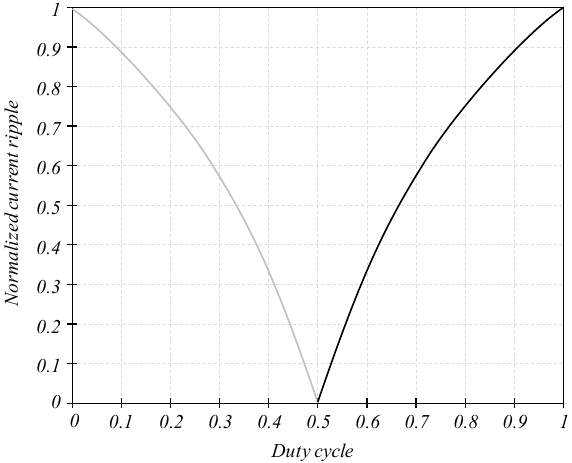
Figure 7. Normalized input current ripple vs. duty cycle. The maximum value of the normalized current ripple is equal to 1, indicating the current ripple’s input current ripple is equal to the current ripple in one inductor. In a traditional boost converter, the input current ripple is equal to the inductor current ripple, and then, having a smaller ripple is the advantage of interleaved topologies. Furthermore, when the current is split among different inductors, the maximum stored energy (which depends on the square of the current)